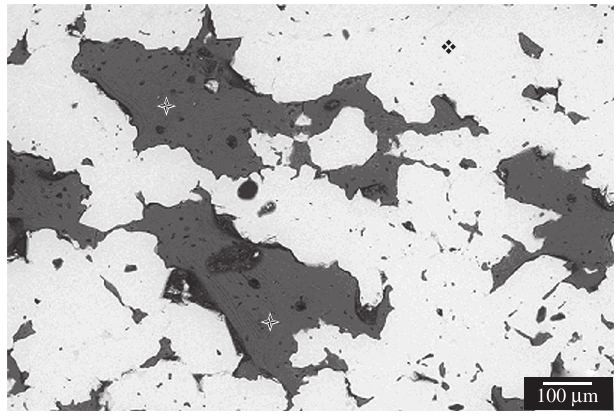
Figure 8. SEM photomicrograph of porous titanium scaffold (  ) 8 weeks after implantation: pore filled with bone (  ).